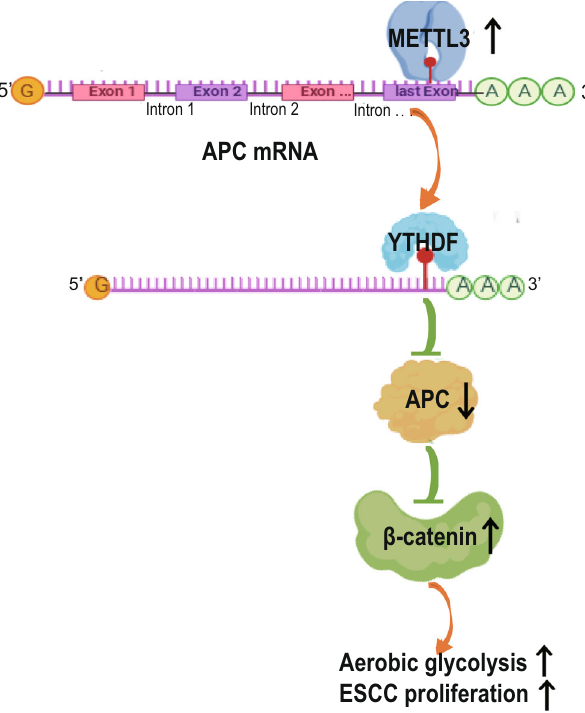
Fig. 8 A mechanism underlying METTL3-promoted ESCC development. Overexpressed METTL3 increases the levels of the APC mRNA N 6 -methyladenosine, which recruits YTHDF to APC mRNA, to downregulate APC expression. Downregulated APC stabilizes β -catenin expression and promotes β -catenin-dependent gene expression for aerobic glycolysis, and ESCC cell proliferation and tumour (Fig. 7f). These results suggest that downregulated APC expres- sion correlates with upregulated METTL3 expression in human ESCC specimens and poor prognosis of ESCC patients.